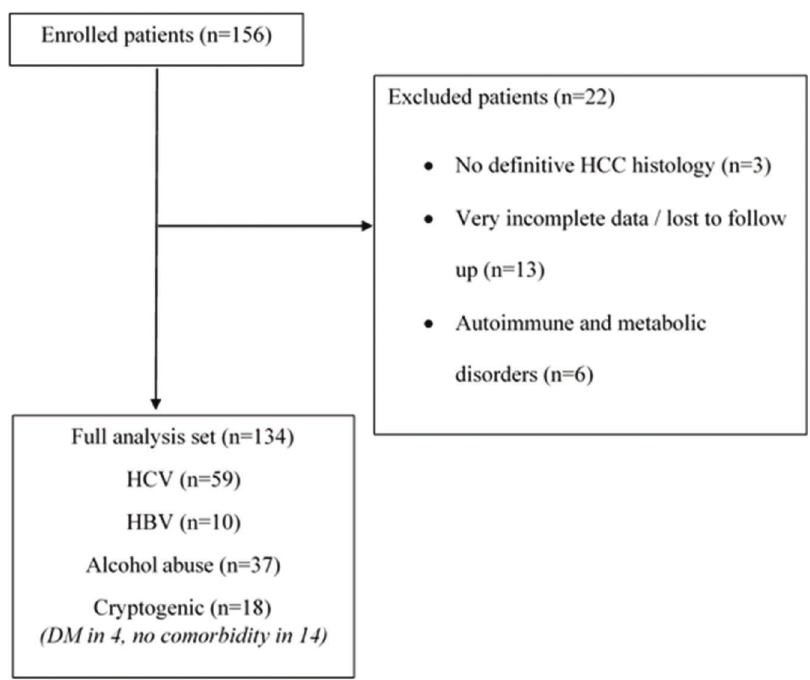
Figure 1 - Study diagram flow. HCC: hepatocellular carcinoma; HBV: hepatitis B virus; HCV: hepatitis C virus; DM: diabetes